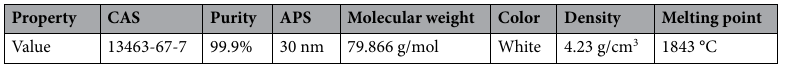
Table 2. The physical and mechanical properties of neat TiO 2 NPs.